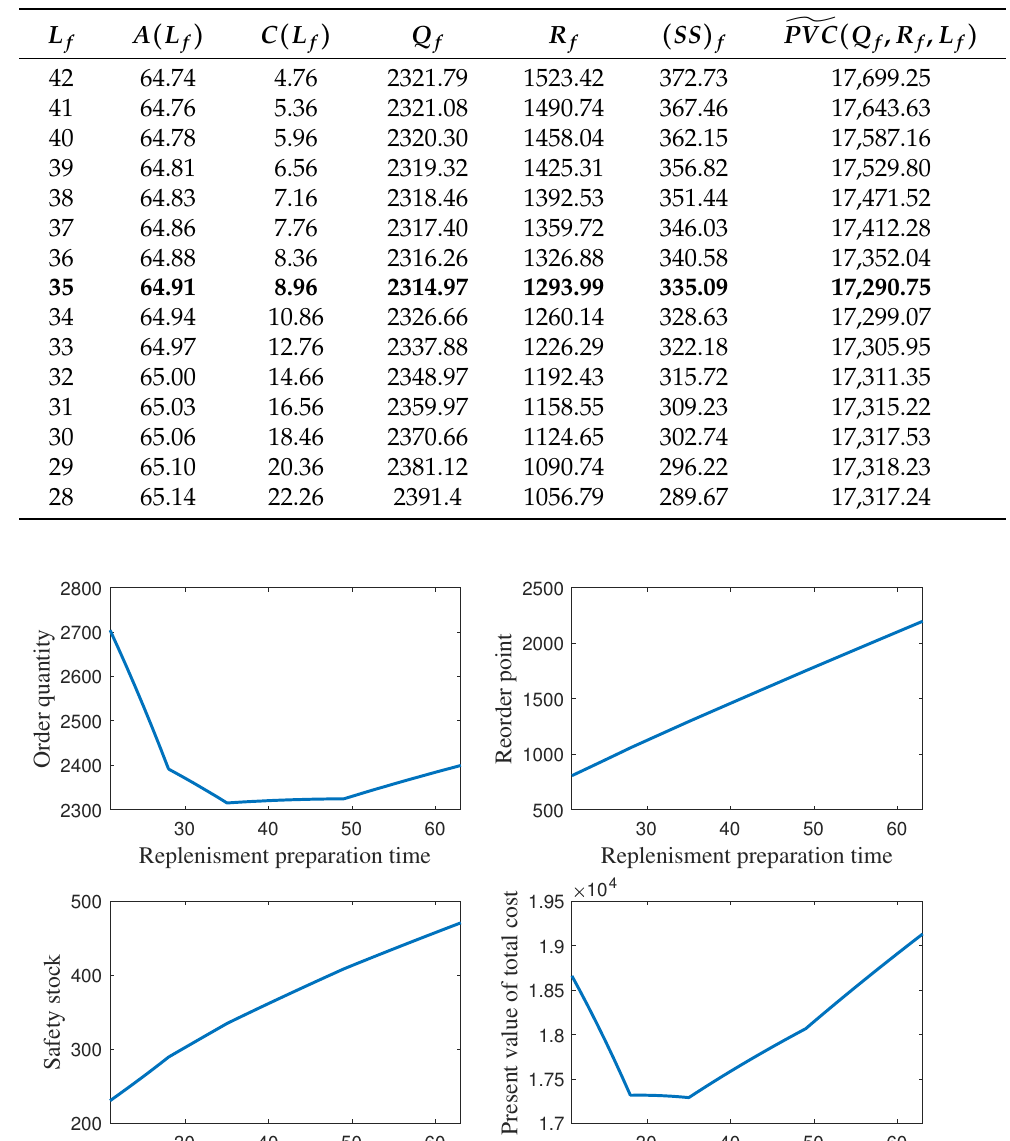
Table 6. Optimal solution for the fuzzy stochastic model.